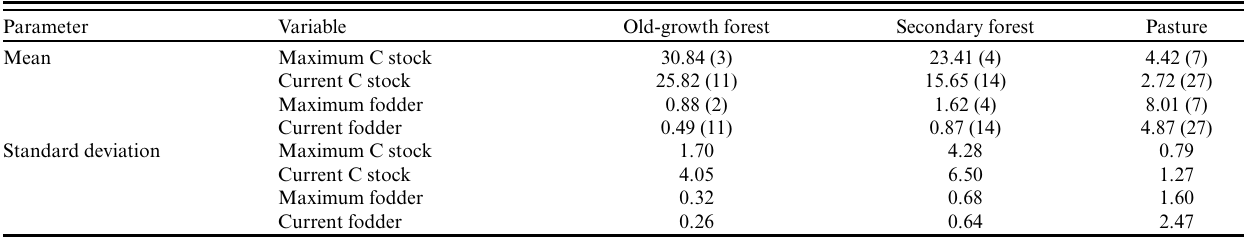
Table 1 . Plot level parameter values used for the calculation of landscape-level efficiency frontiers and current landscape efficiency. C stock refers to carbon in above-ground biomass. Fodder refers to biomass in plants of DBH < 1 cm. Values in parenthesis are sample sizes from which the parameter values were estimated. All values are in Mg